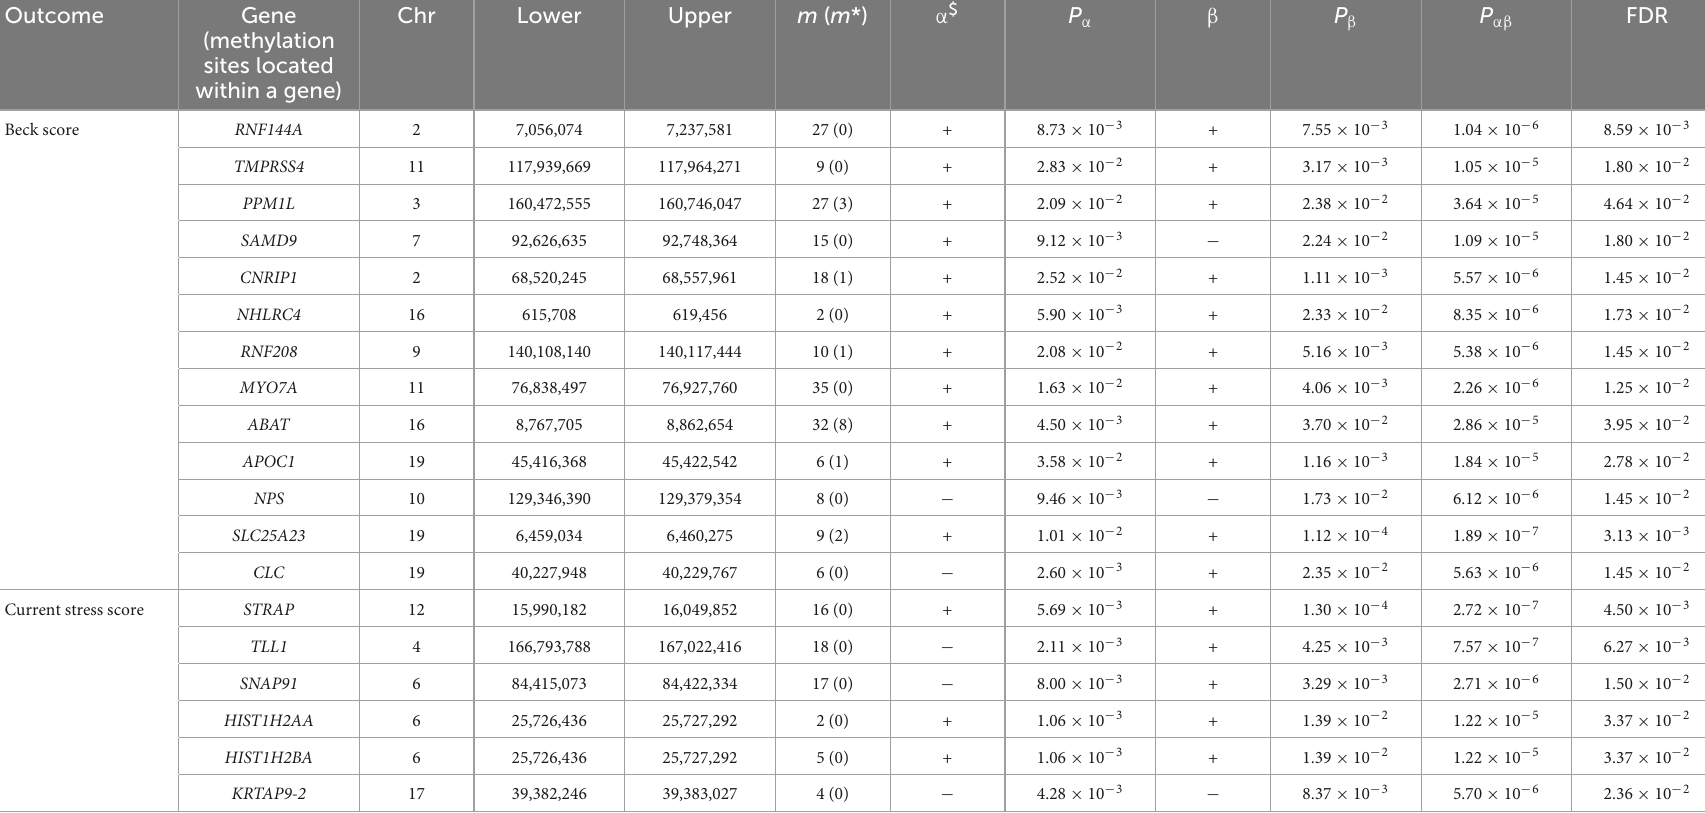
TABLE 3 Located genes of DNA methylation CpG sites with mediation effects for the Beck depression inventory total score and the current stress score.